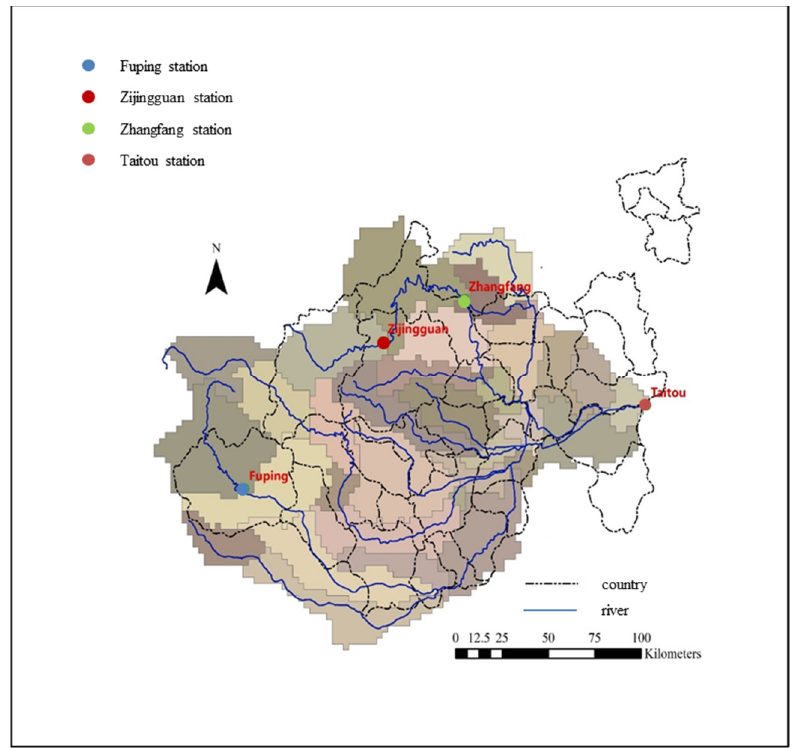
Figure 3. Schematic diagram of sub-basin division in the Daqing River Basin.